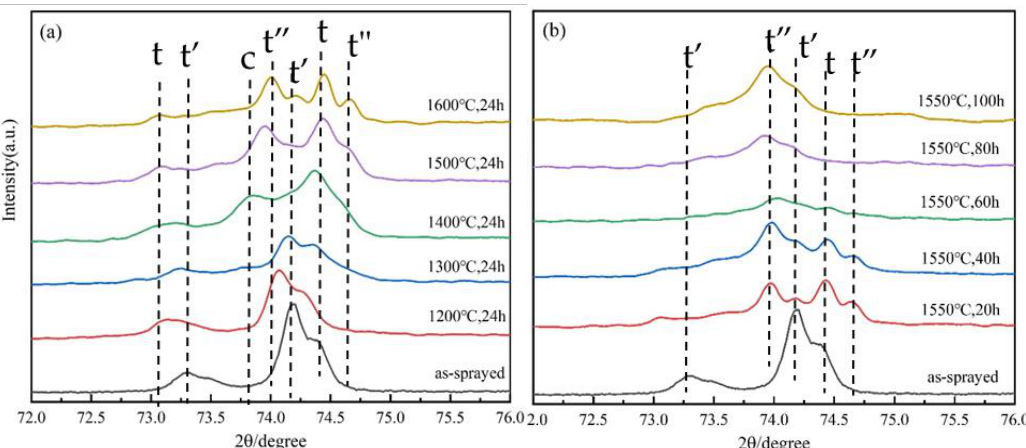
Figure 3. XRD patterns of the powder, as-sprayed coating and the coatings after thermal aging treatment with 2θ between 72° and 76°: ( a ) top coatings after aging for 24 h at different temperatures ( b ) top coatings after aging at 1550 °C for different times.